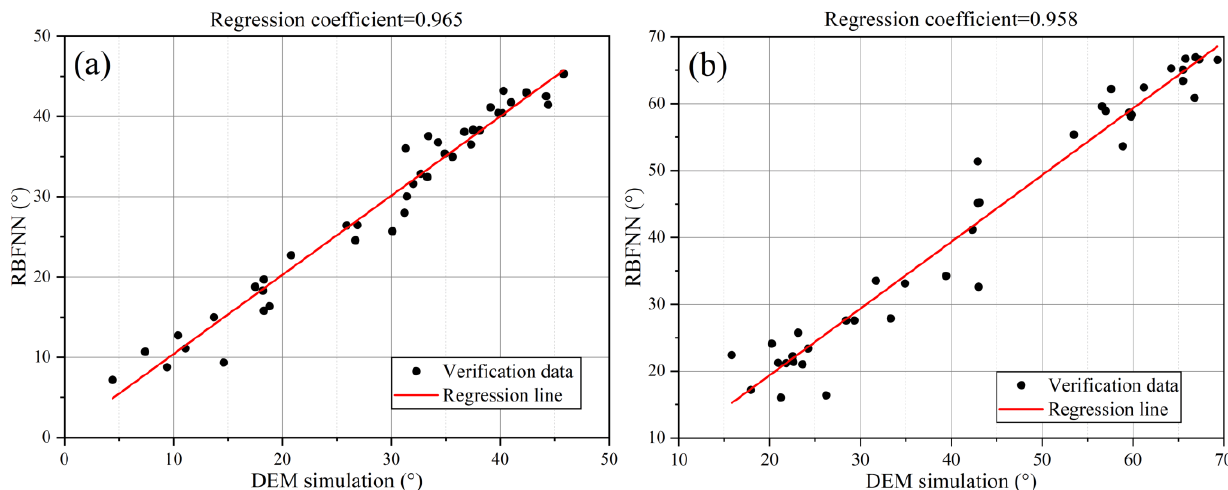
Figure 11. Validated solutions for 40 sets of objective functions: ( a ) α AoR_S ; ( b ) β AoR_D.